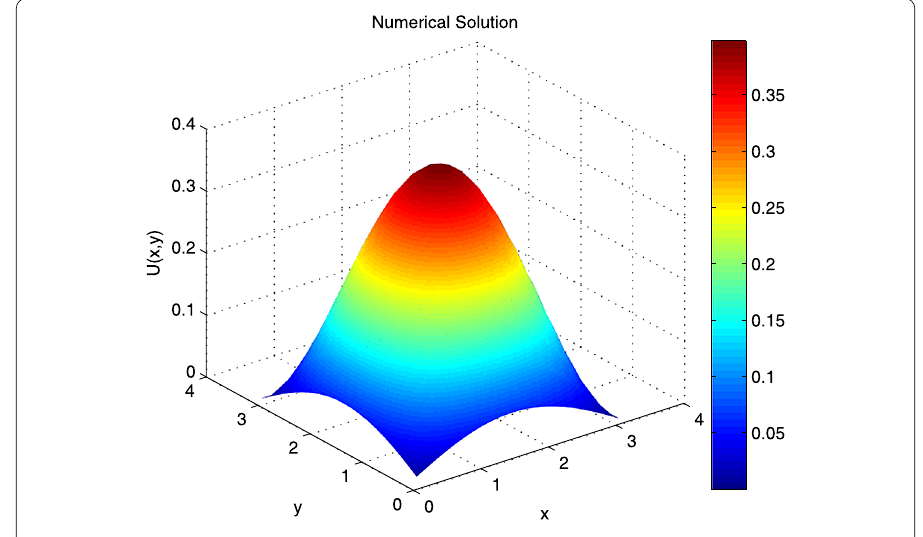
Figure 2 The profile of the numerical solution for the EFK equation with γ = 0.01 at t = T = 1.